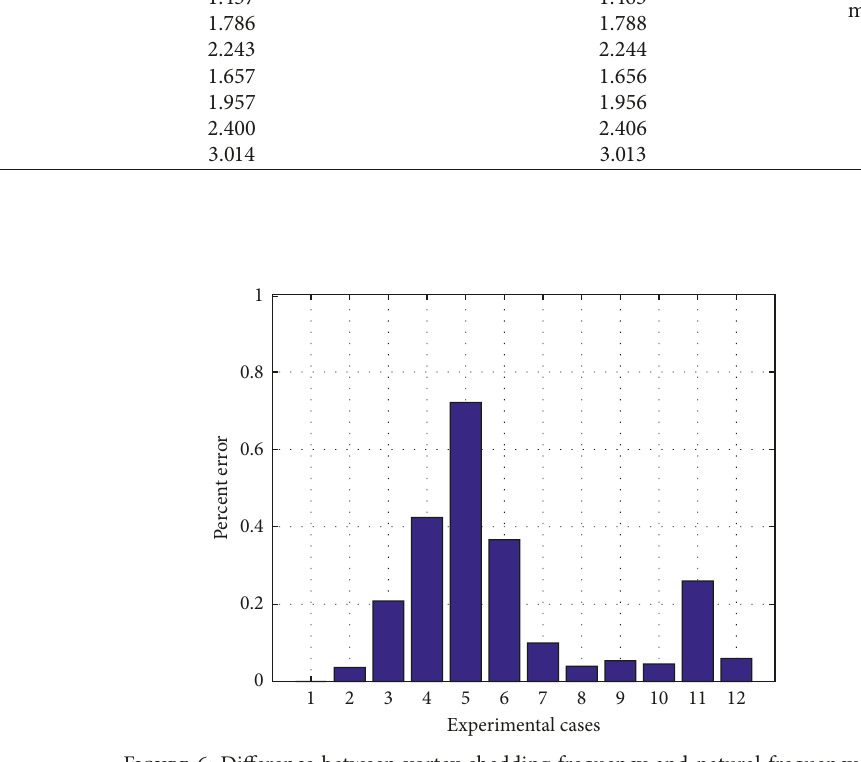
Figure 6: Difference between vortex shedding frequency and natural frequency.